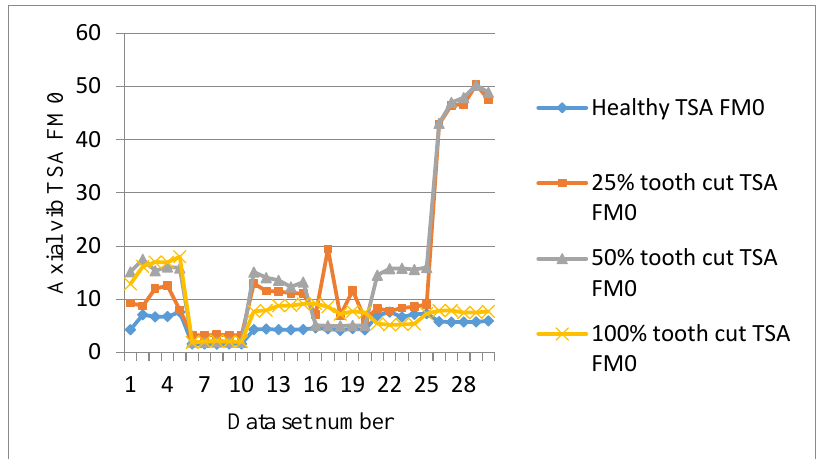
Figure 13. FM0 of the axial vibration TSA